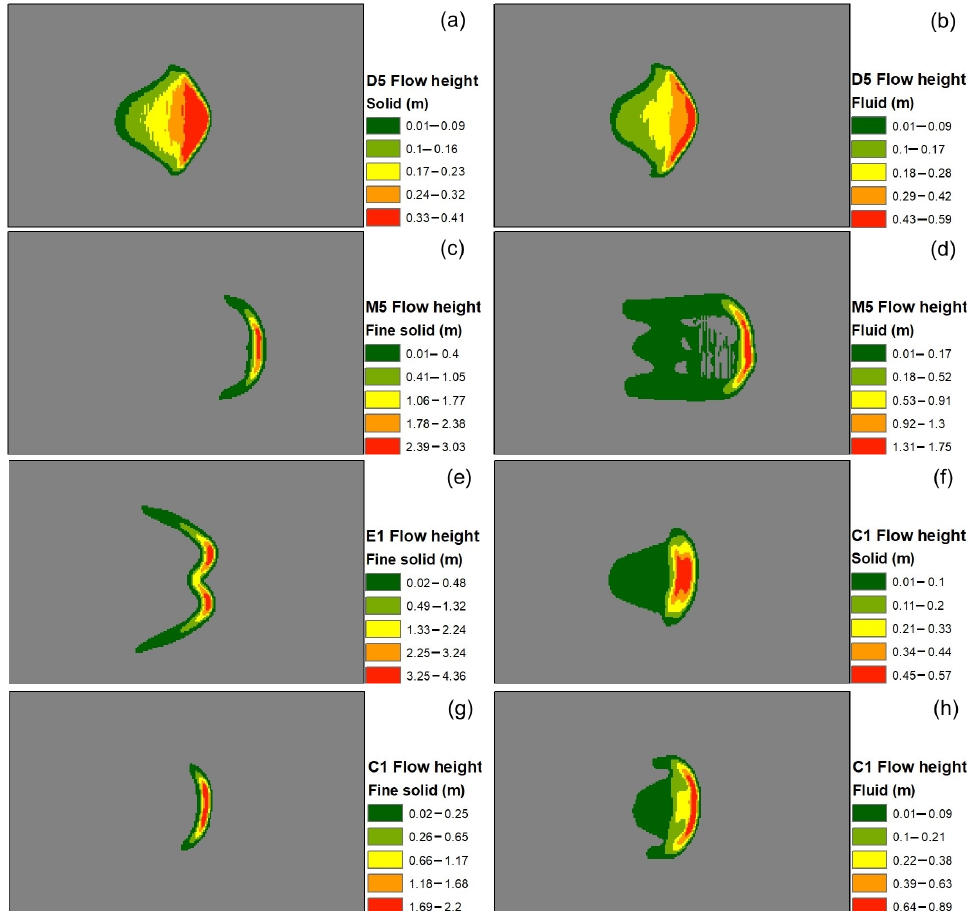
Figure 7. Top view for the height of flow for individual phases at 30 s for ( a ) D5: solid; ( b ) D5: fluid; ( c ) M5: fine solid; ( d ) M5: fluid; ( e ) E1: fine solid; ( f ) C1: solid; ( g ) C1: fine solid; ( h ) C1: